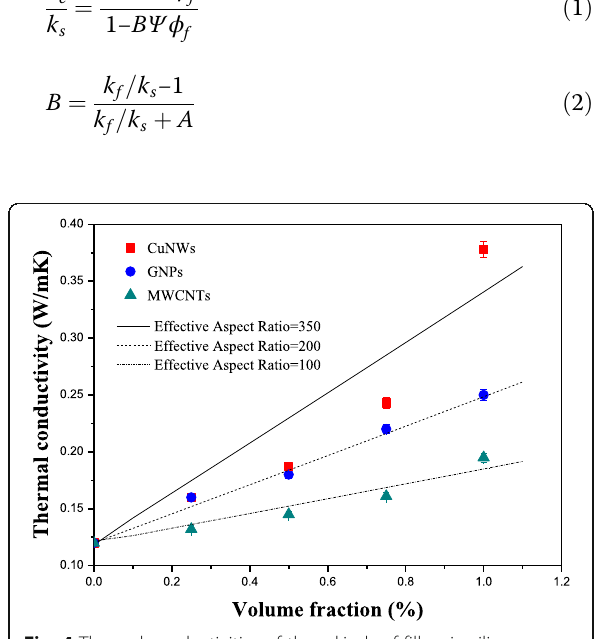
Fig. 4 Thermal conductivities of three kinds of fillers in silicone composites with the predictions by the Nielsen